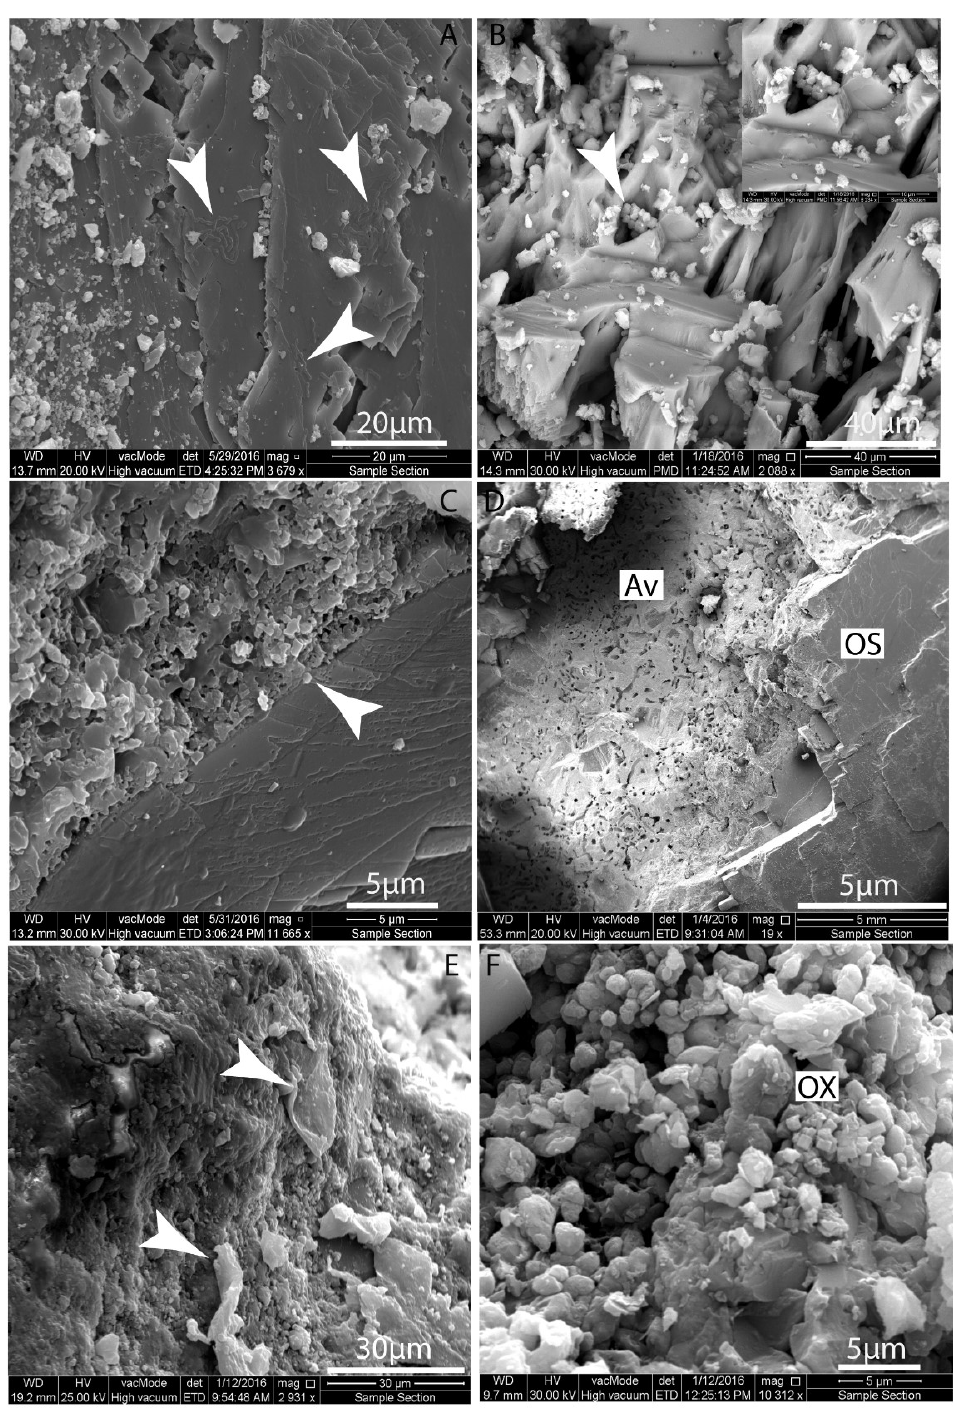
Figure 13. ( A – F ) SEM photomicrographs showing biological influences on the original carbonate substrate. ( A ) Coccoidal rod-shaped bacteria arranged in chain form and tightly linked (arrows), attached to the original surface. Sua.9. Sulauk section. ( B ) New biominerals, probably pseudomorphs of Ca / Mg oxalate minerals, precipitated inside dissolved cavities between unaltered substrate (see arrow and enlarged part in the right upper part). Sp.7. Spelek section. ( C ) The boundary between dissolved and partly dissolved original substrate is clearly shown (arrow). The right part shows the traces of bacterial reaction to the surface of the substrate, while the left part mostly shows the dissolved the substrate. Sua.9. Sulauk section. ( D ) The distinction between soil products (Av) and the original surface of the carbonate (OS) is shown. The in situ brecciation of root and rootlets of the plant giving an alveolar texture (Av) indicates the role of biogenic diagenesis in the area. Sp.11.